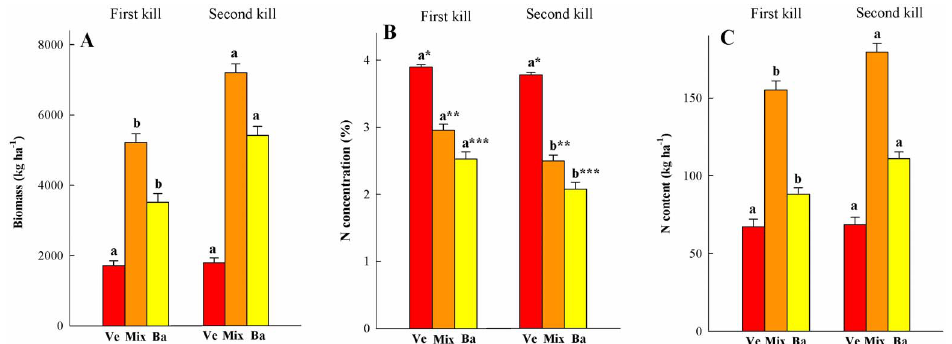
Figure 3. Biomass (A), N concentration (B) and N content (C) for vetch (Ve), barley (Ba) and the mixture (Mix) measured for the first and second kill dates. Values are the mean of two cropping seasons. Letters above bars show significant differences between kill dates for each species, and asterisks between species for each kill date. Small bars represent the standard error.